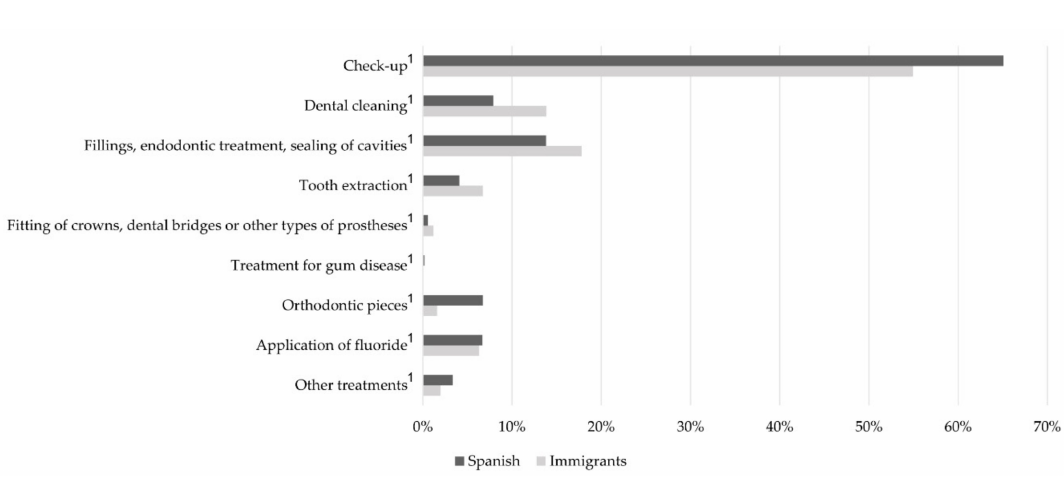
Figure 1. Type of assistance received at the dentist, stomatologist or dental hygienist for the population of Spanish and immigrant children and adolescents. Spanish National Health Survey, 2017. The graph shows the Spanish and immigrant child population (black and grey segments, respectively). 1 p < 0.001 by Fisher’s exact